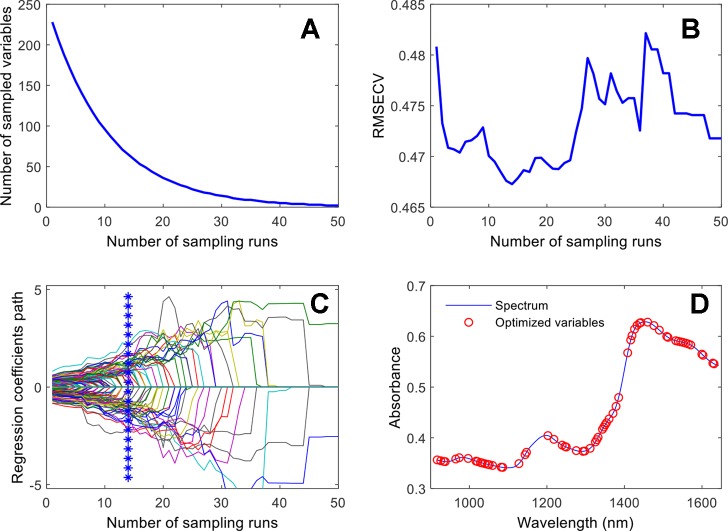
Wavelength-variable screening by CARS: (A) number of sampled variables versus number of sampling runs; (B) RMSECV versus number of sampling runs; (C) regression coefficients path versus number of sampling runs; (D) wavelength variables selected by CARS.